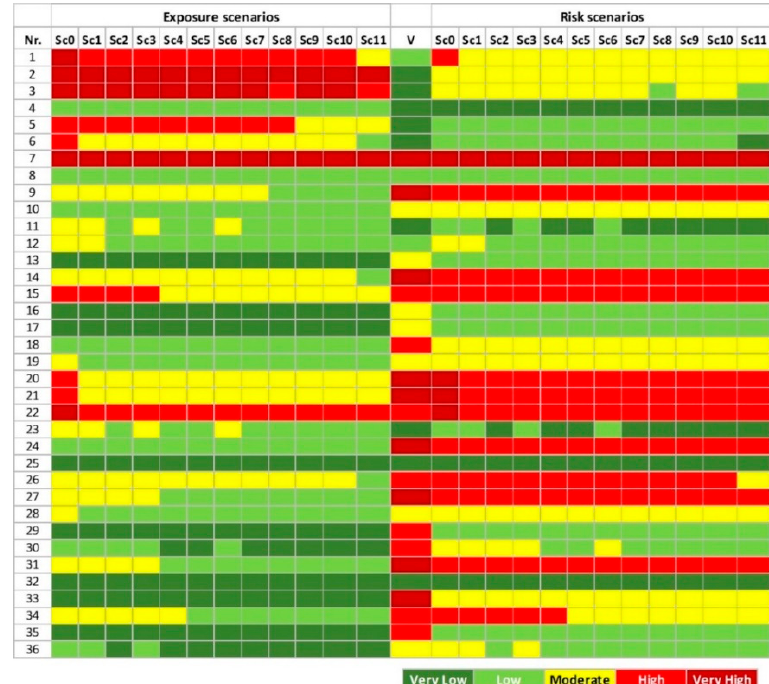
Figure 9. Heatmap with coloured classes for the risk components (exposure; V-vulnerability; risk) in each settlement, considering the different scenarios (Sc0–business-as-usual, to Sc11–high forest management combined with the full implementation of a fuel break network. See Table 3 for details).